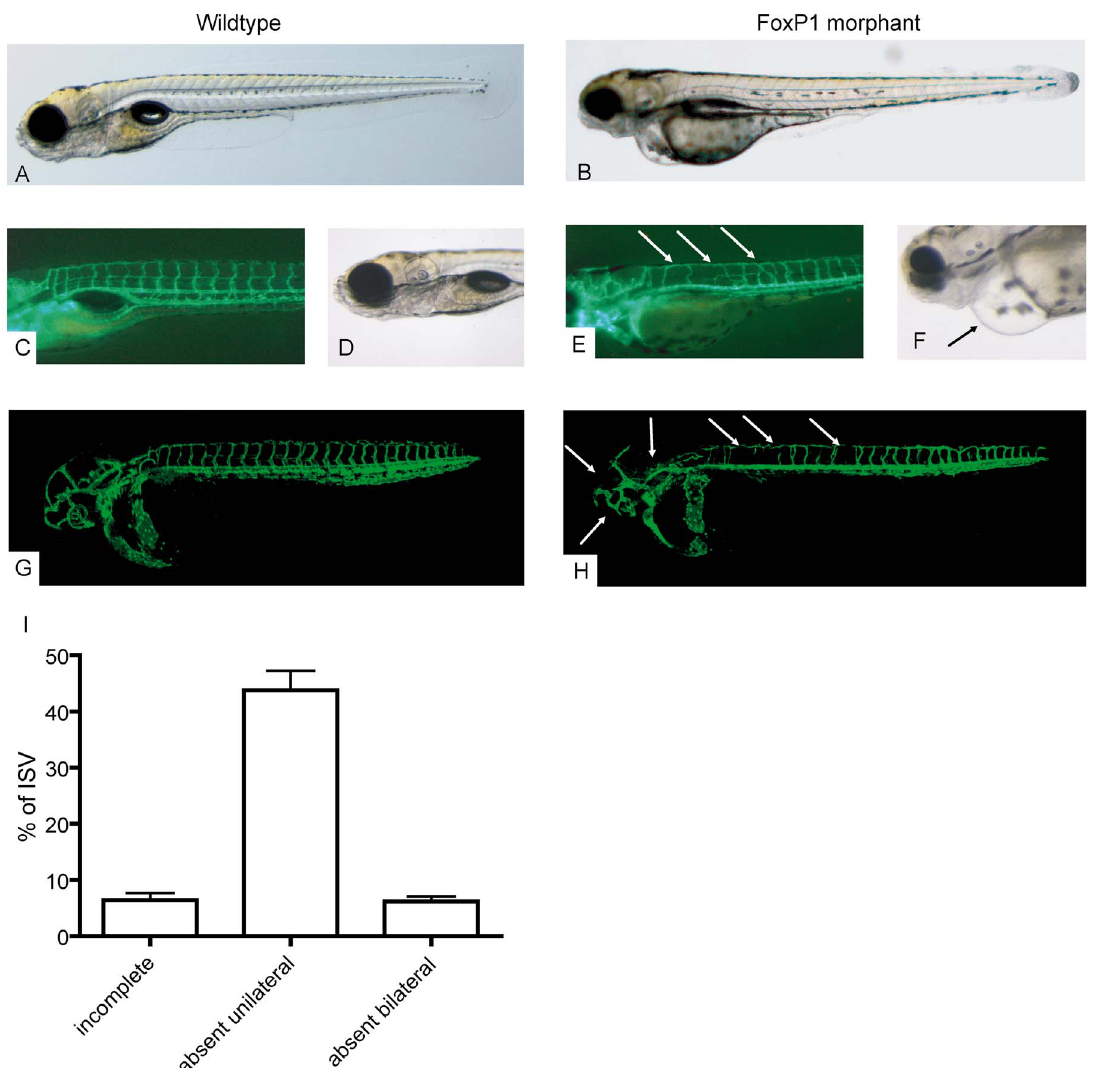
Figure 4. FoxP1 modulates blood vessel development in vivo. (A&B) No gross developmental defects were observed after FoxP1 silencing in Tg (vegfr4:gfp) s843 fish, that allow fluorescent imaging of cardiovascular development. The combined silencing of the two zebrafish paralogues of FoxP1 FoxP1a and FoxP1b by injection of two morpholinos resulted in a specific and reproducible cardiovascular phenotype. FoxP1 knockdown impaired vascular (E) and cardiac (F + G) development. At day 5 post fertilization, most ISVs of the trunk remained missing or incomplete (E). Confocal imaging (G&H) revealed that most ISV that eventually sprouted from the dorsal aorta did not follow the normal intersomitic pathways, but penetrated intersomitic boundaries (depicted by arrows, Quantification: I). Cerebrovascular development was also impaired